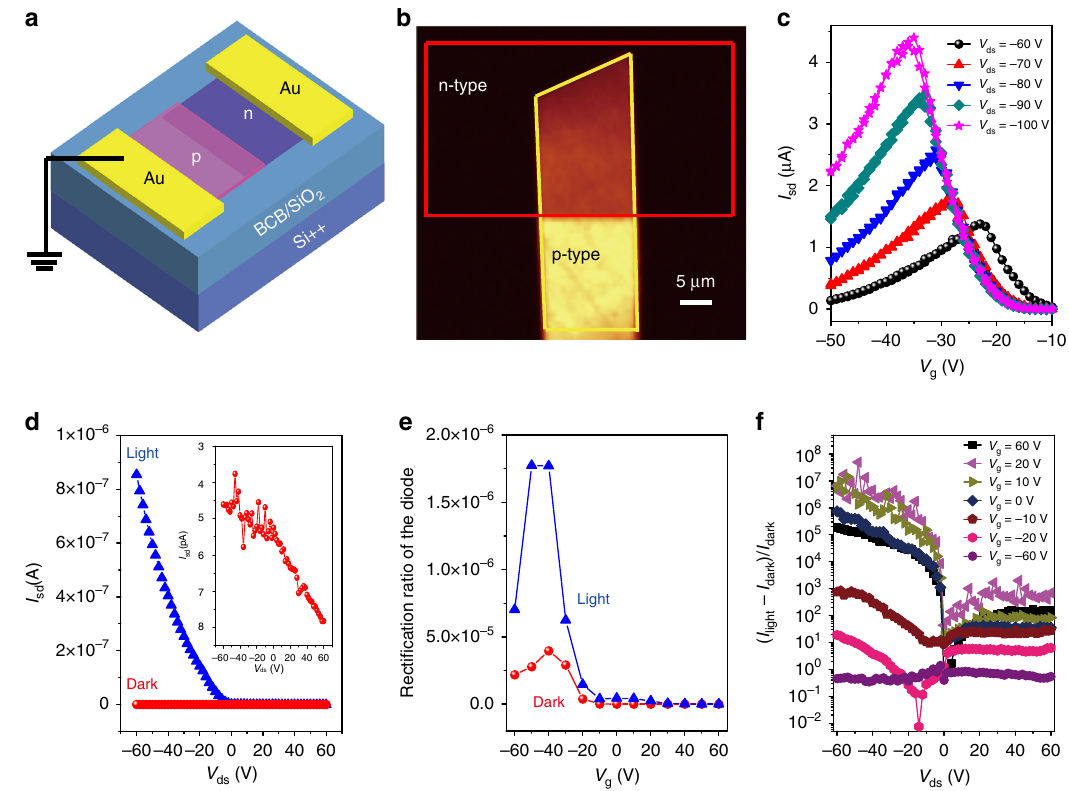
Fig. 4 Optoelectronic characteristics of lateral organic p – n diode. a Schematic diagram of lateral organic p – n diode. The electrode at the p-type side was set grounded. b Fluorescent mapping of p – n diode. c Transfer curves of the p – n diode at V ds = − 60 to − 100 V measured in the dark. d Output characteristics of the p – n diode as gate bias voltage at V g = 60 V under light illumination (blue triangle) and in the dark (red ball) condition. The inset shows the zoom in curves in the dark condition. e Recti fi cation curve of the p – n diode at V ds = ±60 V. Blue triangle is under light illumination and red ball is in the dark condition. f Photosensitivity of the p – n diode at different gate